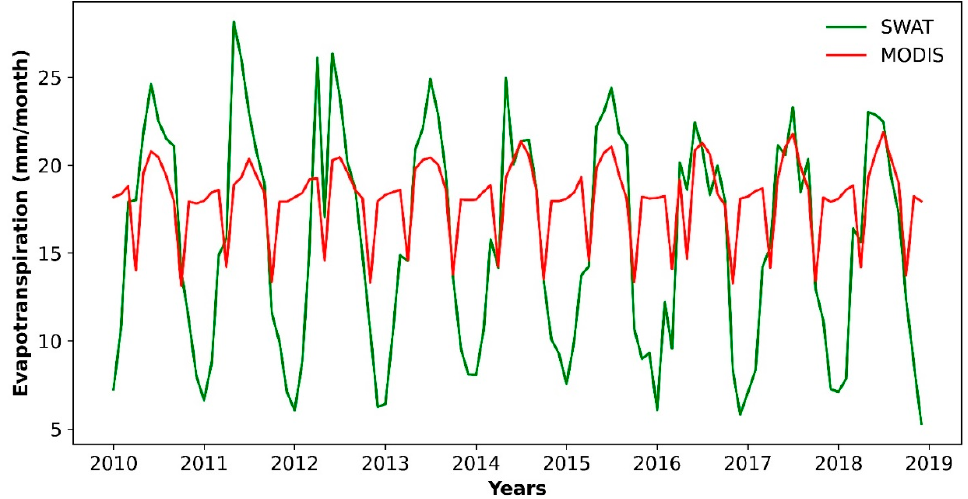
Figure 7. Comparison of monthly SWAT-simulated vs. MODIS evapotranspiration data.